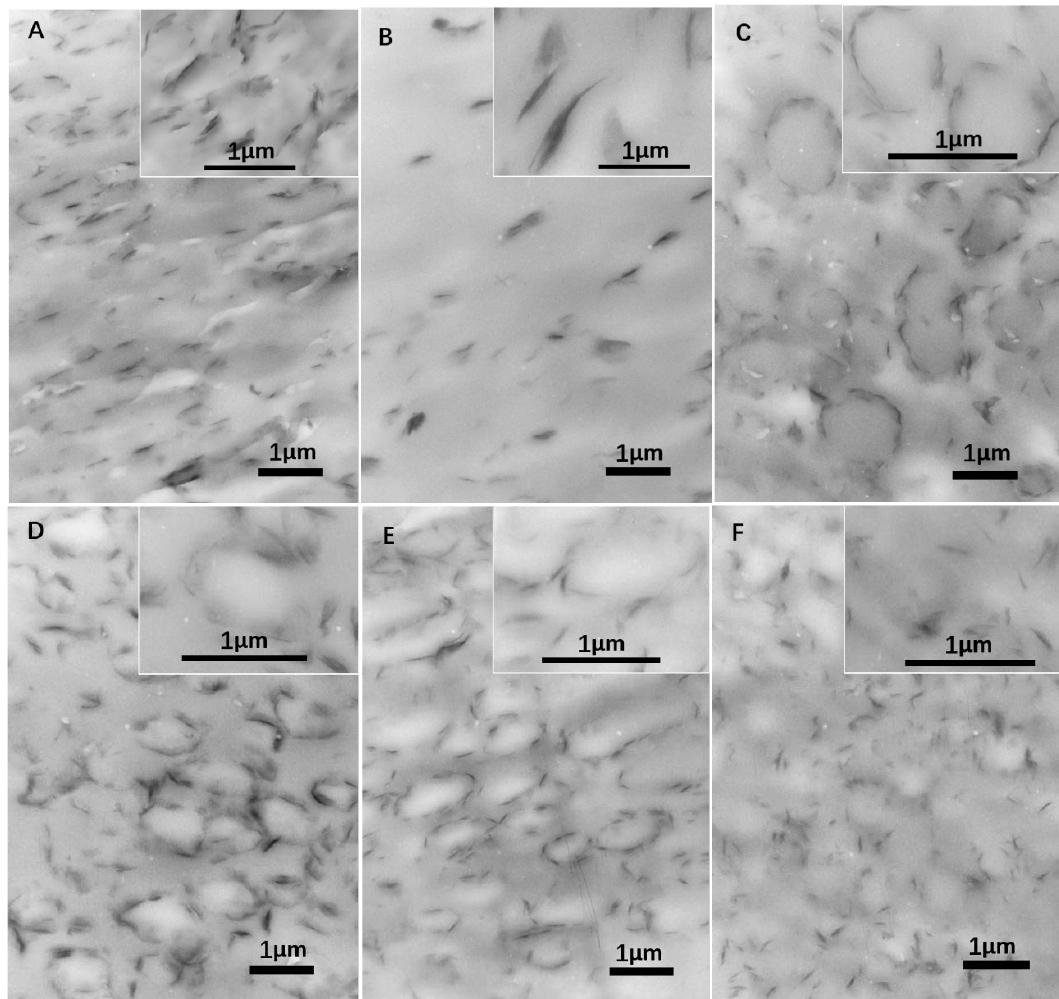
Figure 6. TEM images of the 70/30/MMT PTT/PC blends processed at 240 °C with varied shear rate, processing mode, and MMT (Cloisite ® 25A) loading, with or without epoxy resin. ( A) : 1 wt. % MMT, 60 rpm, (3 + 7) min; ( B ): 1 wt. % MMT, 0.5 wt. % epoxy resin, 60 rpm, (3 + 7) min; ( C ): 1 wt. % MMT, 80 rpm, (3 + 7) min; ( D ): 3 wt. % MMT, 80 rpm, (3 + 7) min; E: 1 wt. % MMT, 100 rpm, (3 + 7) min; F: 1 wt. % MMT, 100 rpm, 10 min.